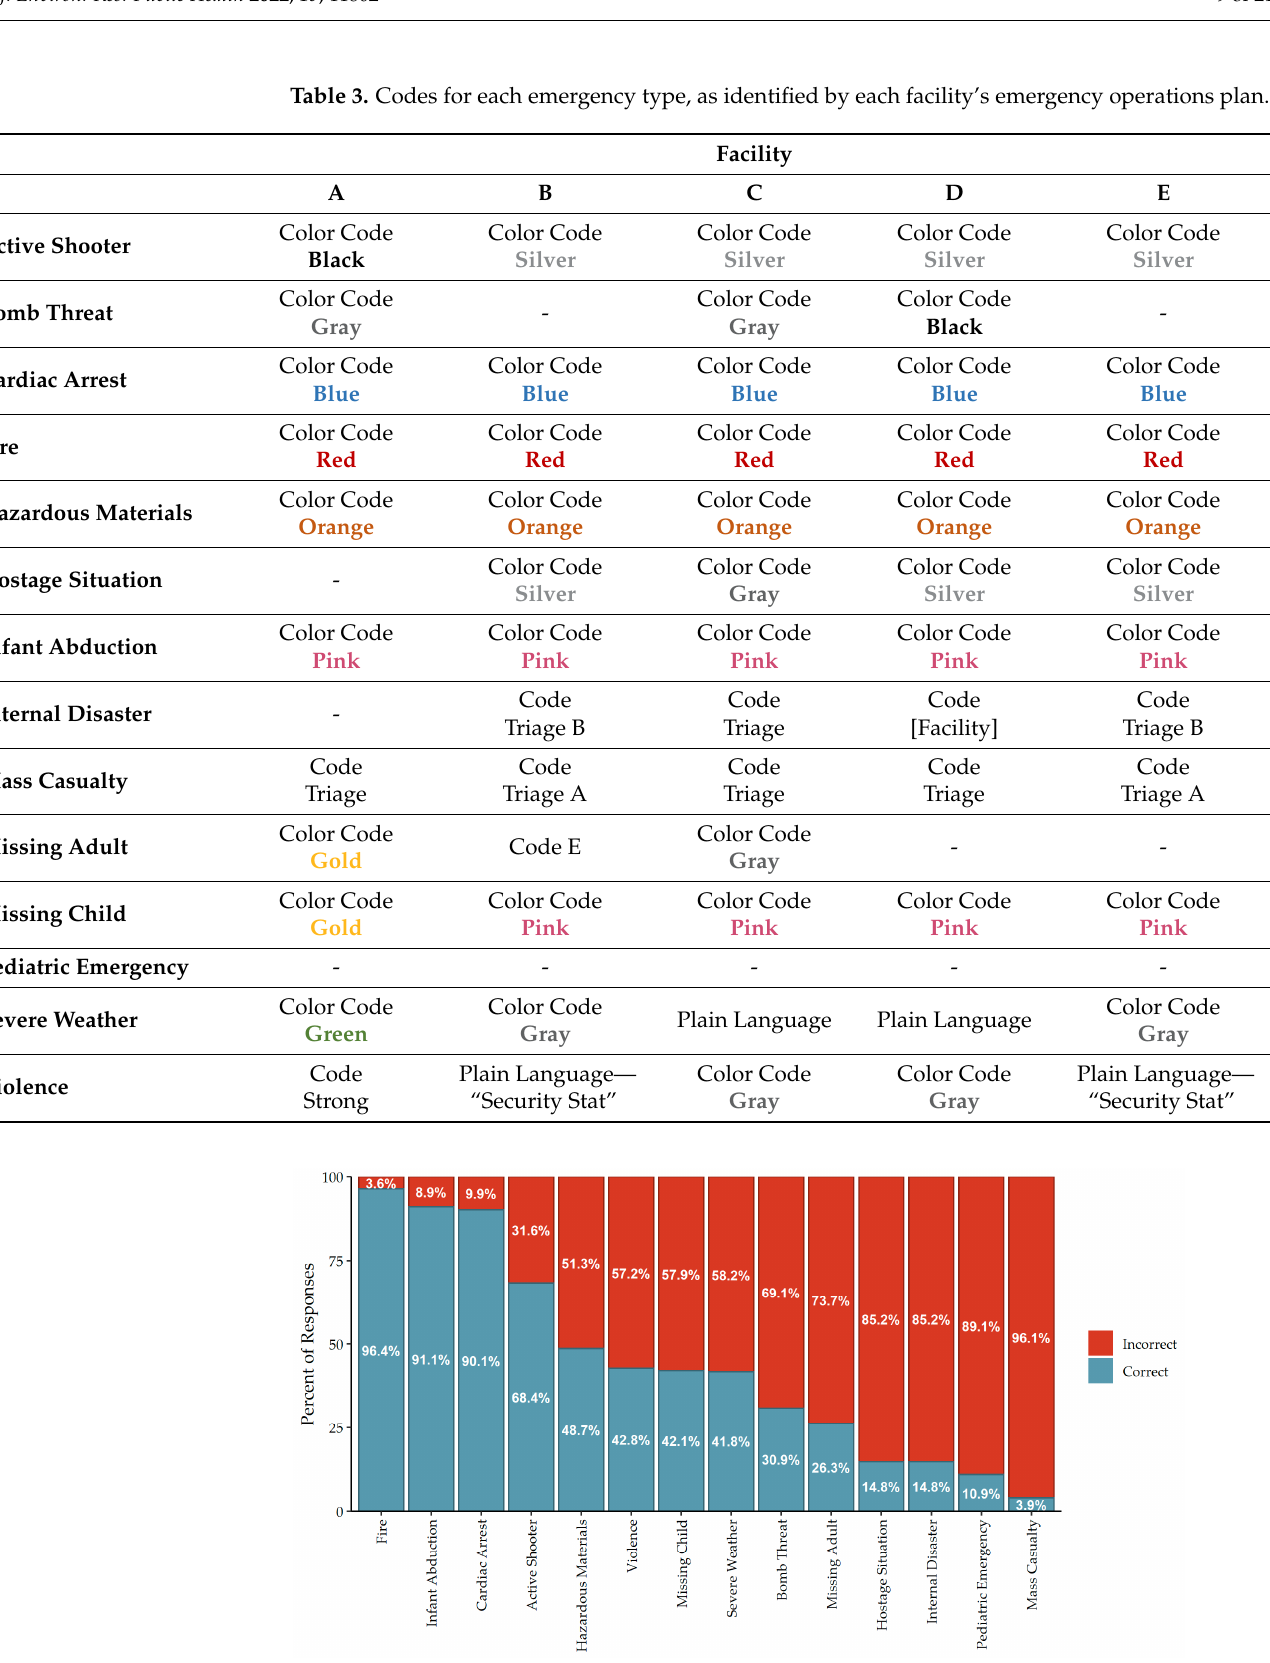
Figure 2. Code identification accuracy by emergency across all participants.